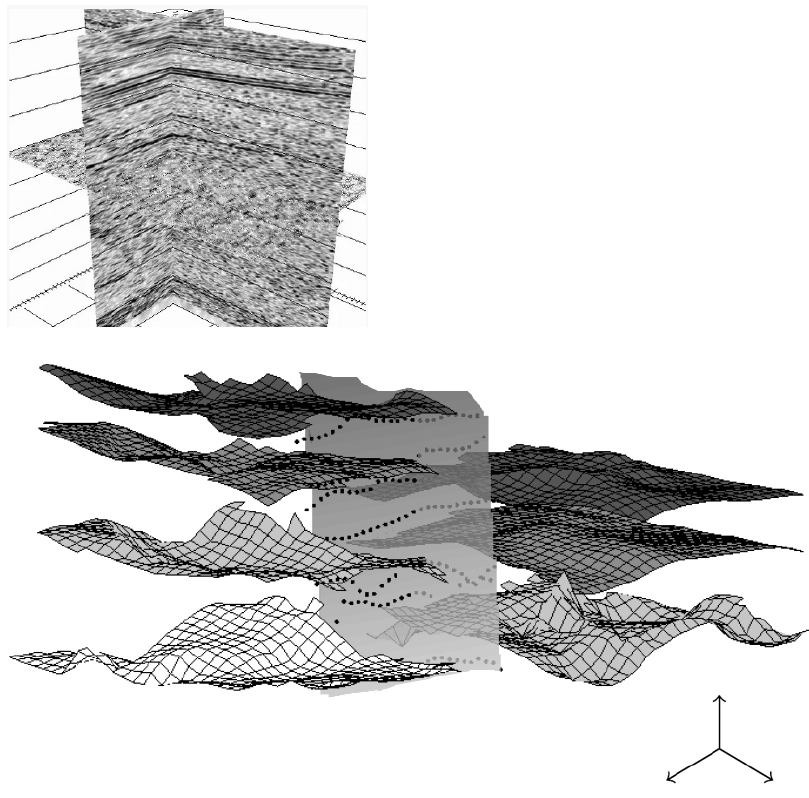
Figure 14. Top : Another 3D view of the 3D geological dataset of Figure 5. Bottom : From the 3D dataset, we use a set of points (well data given by geologists), and each surface/layer is then constructed with a D m -spline operator (see [22] for more details on D m -spline surface